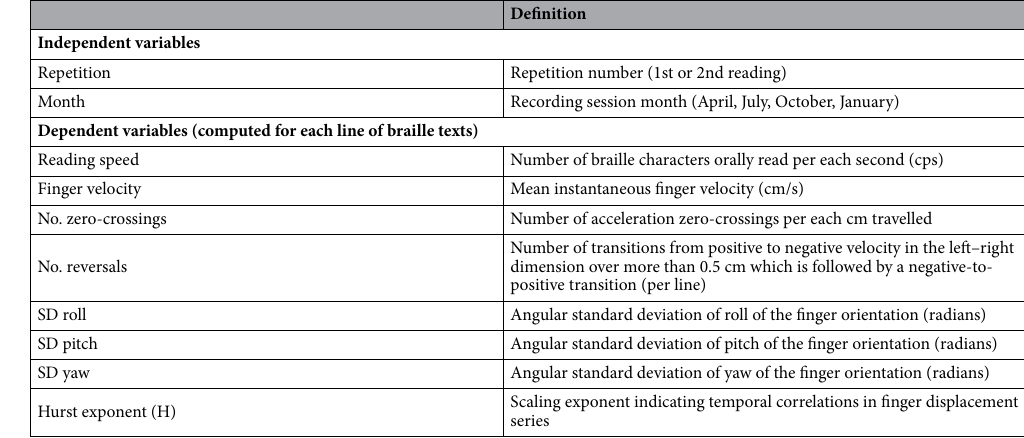
Table 1. Definition of the variables used for the analysis of braille reading behavior.